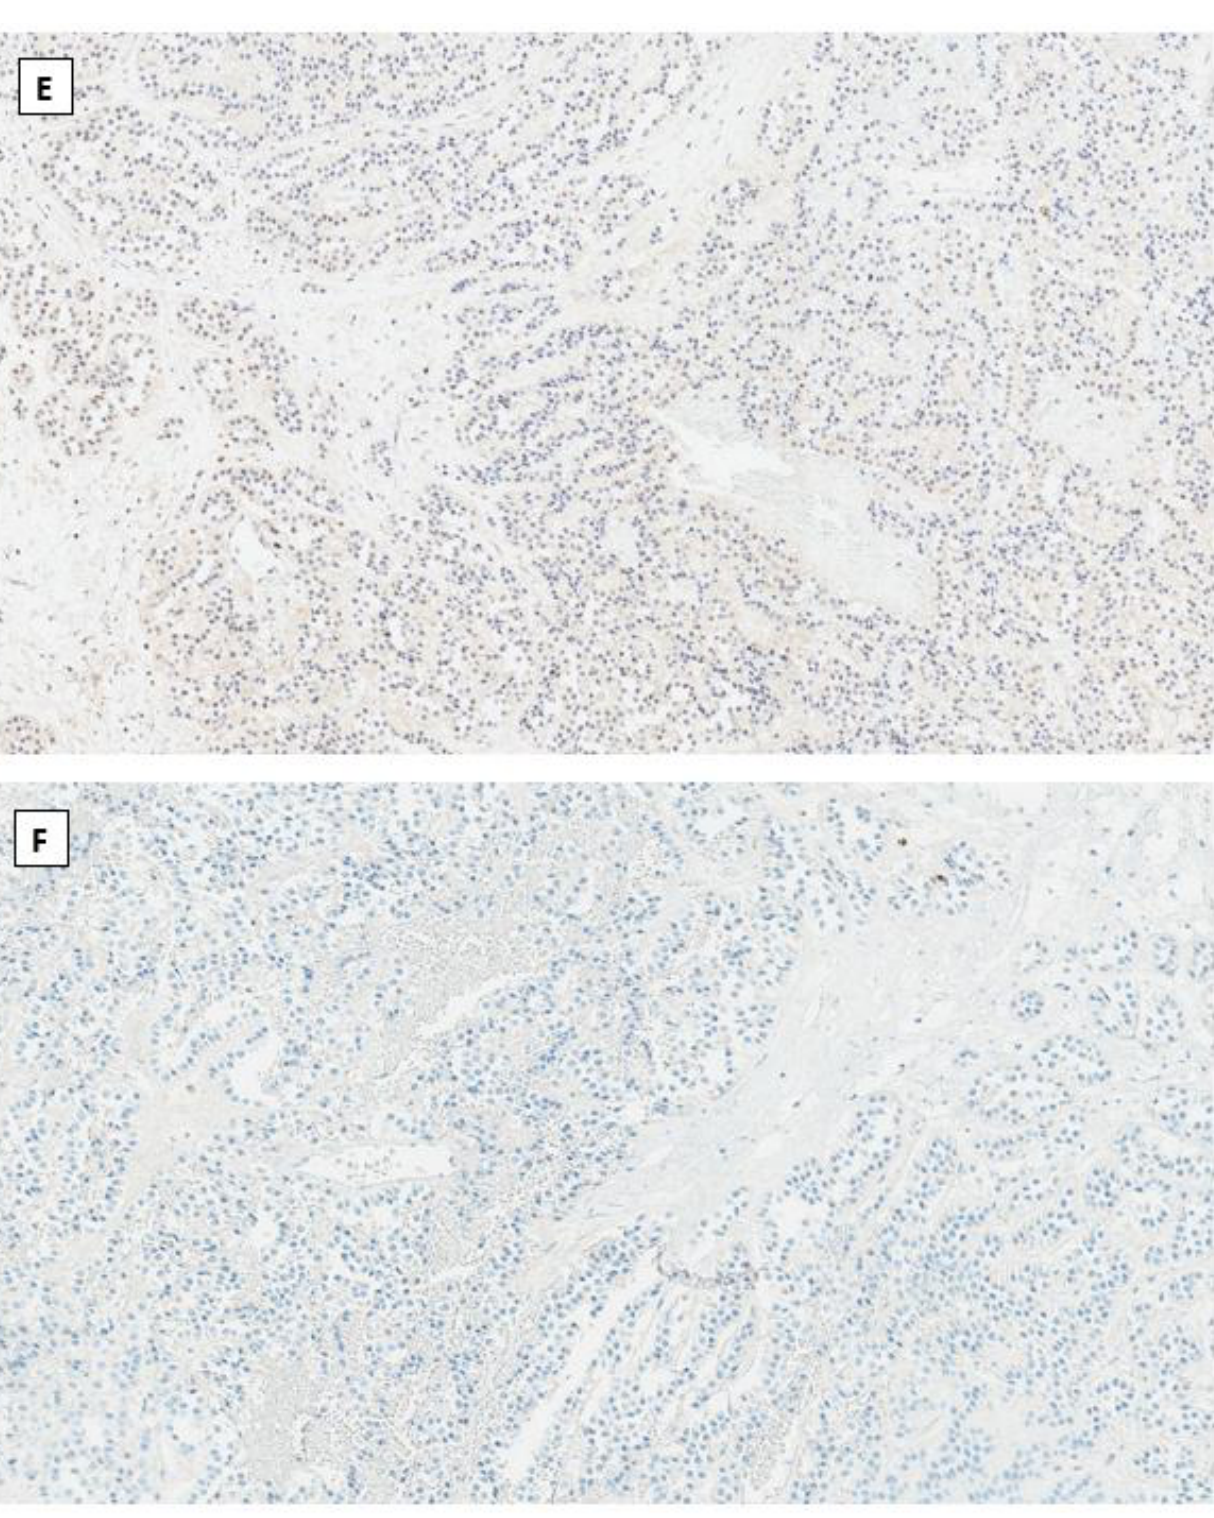
Figure 1. Solid pseudopapillary neoplasm of the ovary. Tumor cells grow in cords and pseudopapillary patterns with blend cytology and abundant delicate vasculature (H&E staining at 40 × magnification for ( A ) and 200 × magnification for ( B )). Immunohistochemical staining demonstrates intense nuclear and cytoplasmic staining of β -catenin ( C ), intense nuclear with weak cytoplasmic staining of LEF-1 ( D ), and negative staining for SF1 ( E ) and inhibin ( F ). Immunostaining for β -catenin is at 200×, and for LEF-1, SF1 and inhibin are at 100× magnifications, respectively.